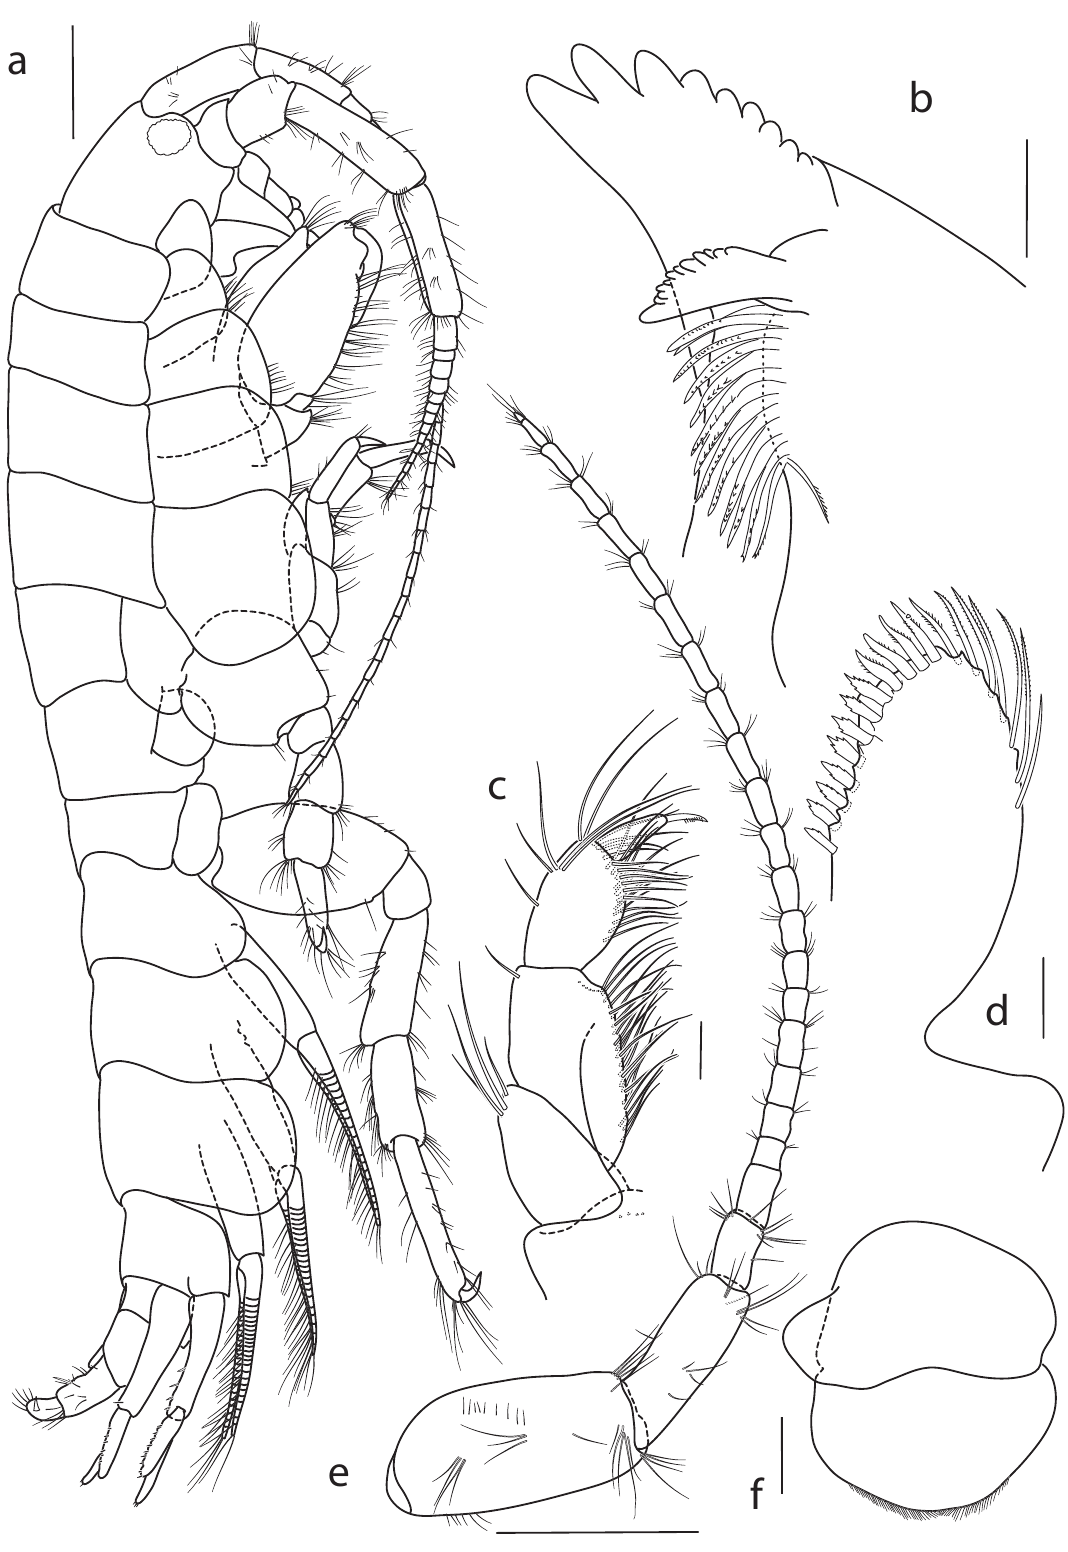
Fig. 1. Sunamphitoe femorata (Krøyer, 1845), ♂, 12 mm (ZMB 34100). a . Habitus, right body side. b . Mandible. c . Palp of maxilliped. d . Outer plate of maxilliped. e . Antenna 1. f . Upper lip and epistome. Scale bars: a = 1 mm; b–d, f = 100 µm; e = 500